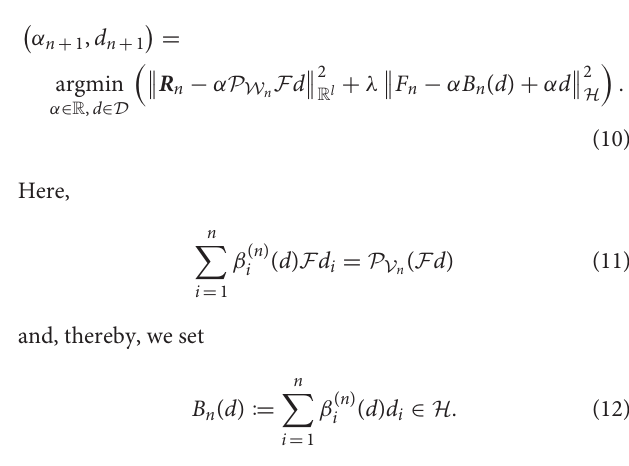
R l and an operator F : H ∈